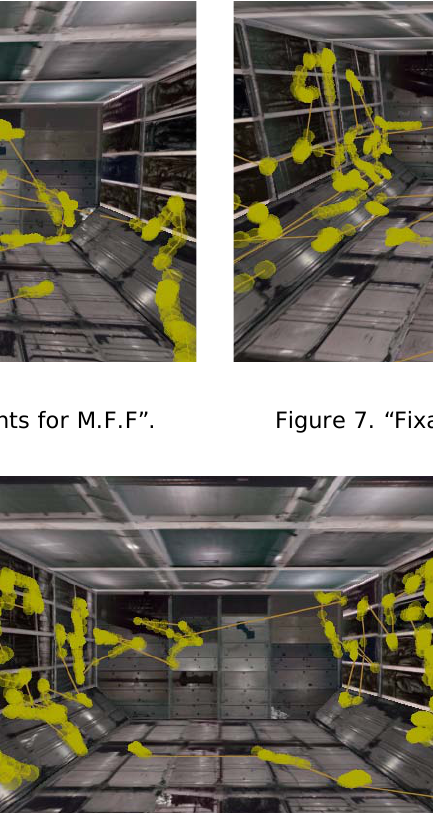
Figure 5. “Number of Fixation Points as a Function of Amount of Feedforward Information Provided”. Source: Own contribution